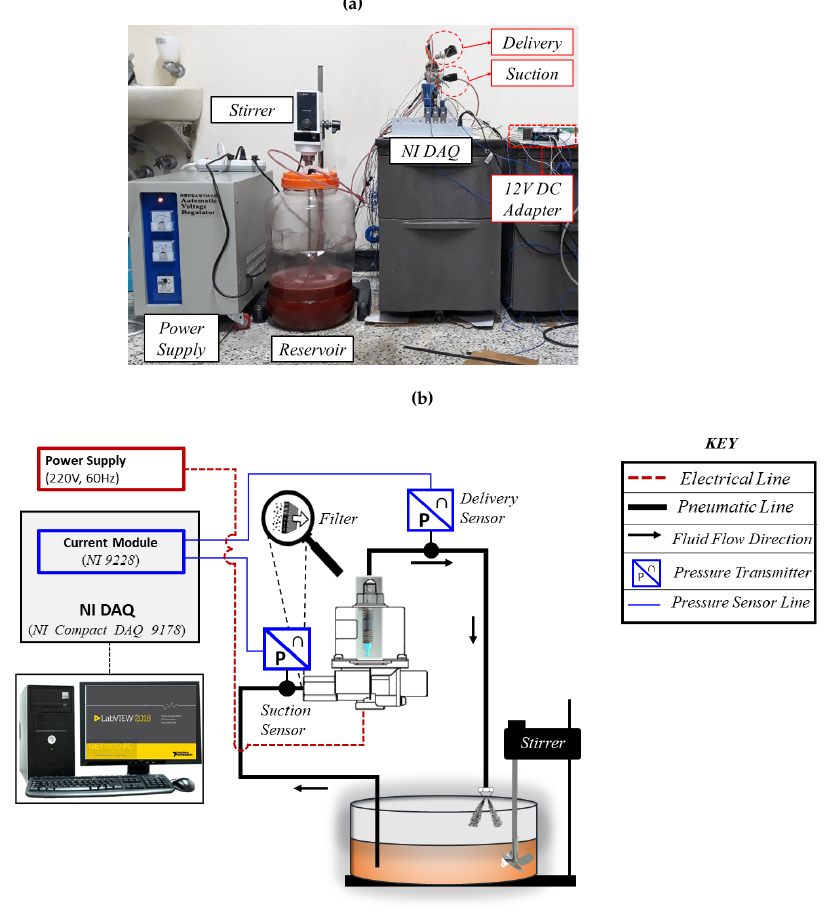
Figure 3. Experimental setup showing ( a ) A picture of the actual testbed ( b ) illustrations for sensor placements and data